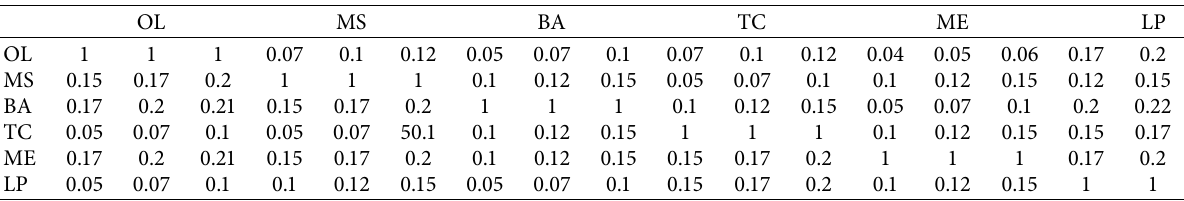
Table 4: Normalized